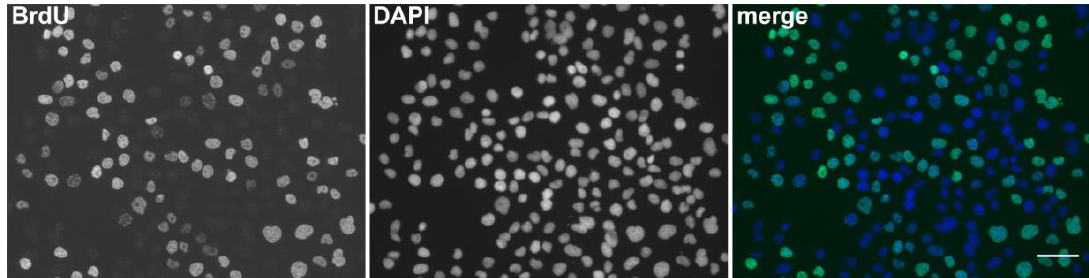
Figure 1. The detection of BrdU using DNase I and exonuclease III. Examples of microscopic images of cell nuclei labeled for 5 min with BrdU and fixed with formaldehyde. The DNA was labeled by DAPI. The scale bar—50 μm. Adapted with permission from Ligasová et al., 2017, Looking for ugly ducklings: The role of the stability of the BrdU-antibody complex and the improved method of the detection of DNA replication. PLoS ONE 12(3): e0174893 [47].